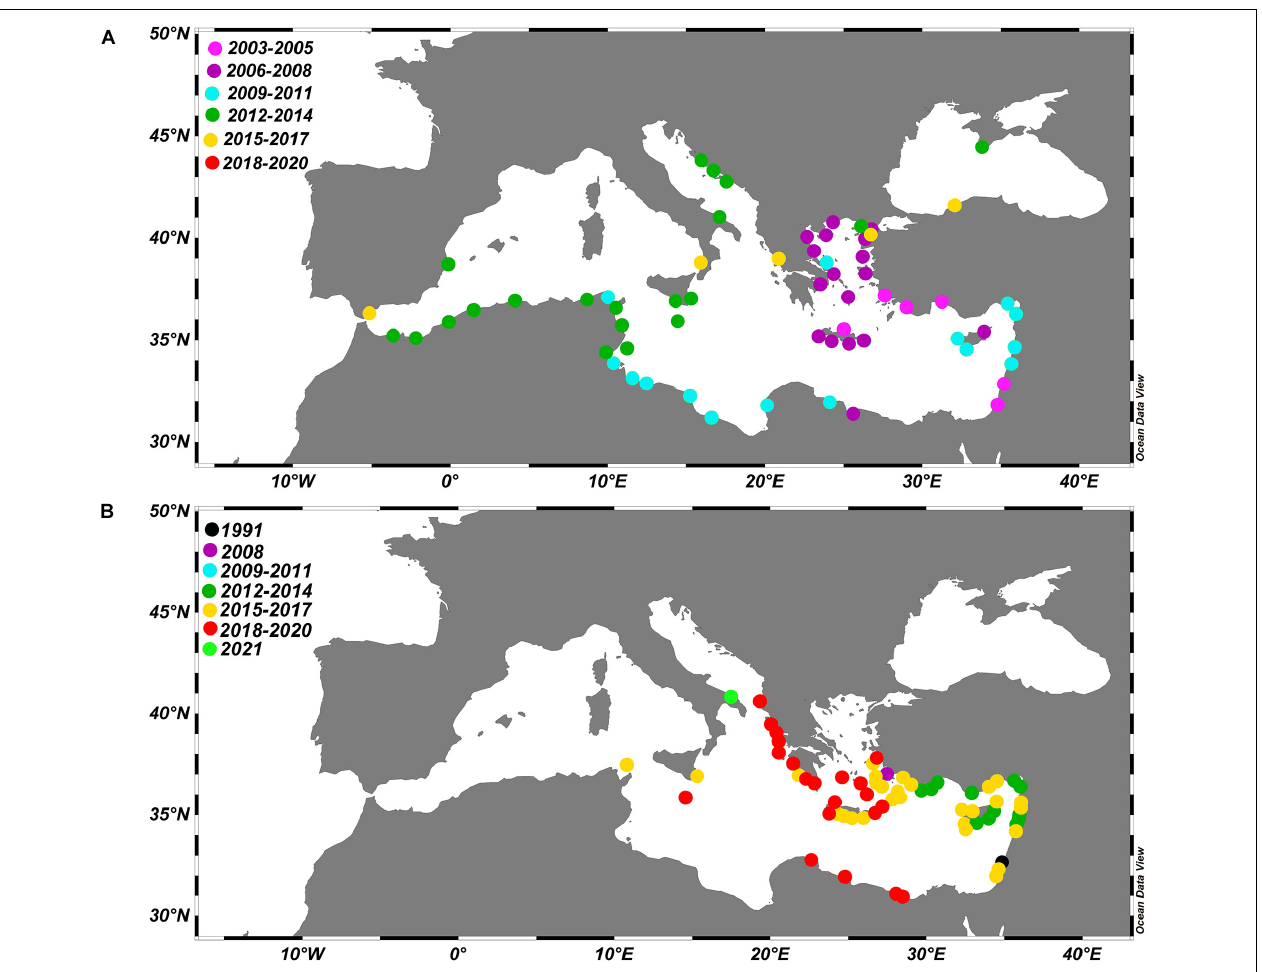
FIGURE 1 | (A) Map of Lagocephalus sceleratus Mediterranean distribution, 2003 to 2017; and (B) map of Pterois miles Mediterranean distribution from 1991 to